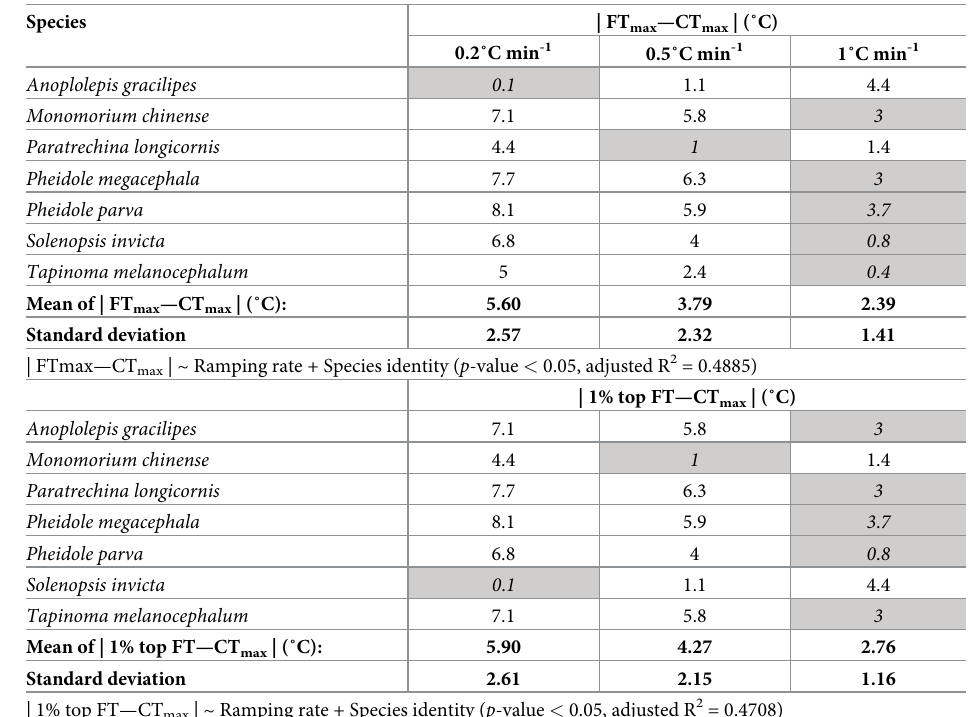
Table 2. The comparsion between CT max values retrevied from three different ramping rates and FT max /1% top FT (sample size of each species shown on Fig 4), the lightly gray color background refers the CT max value, closer to the FT max for those